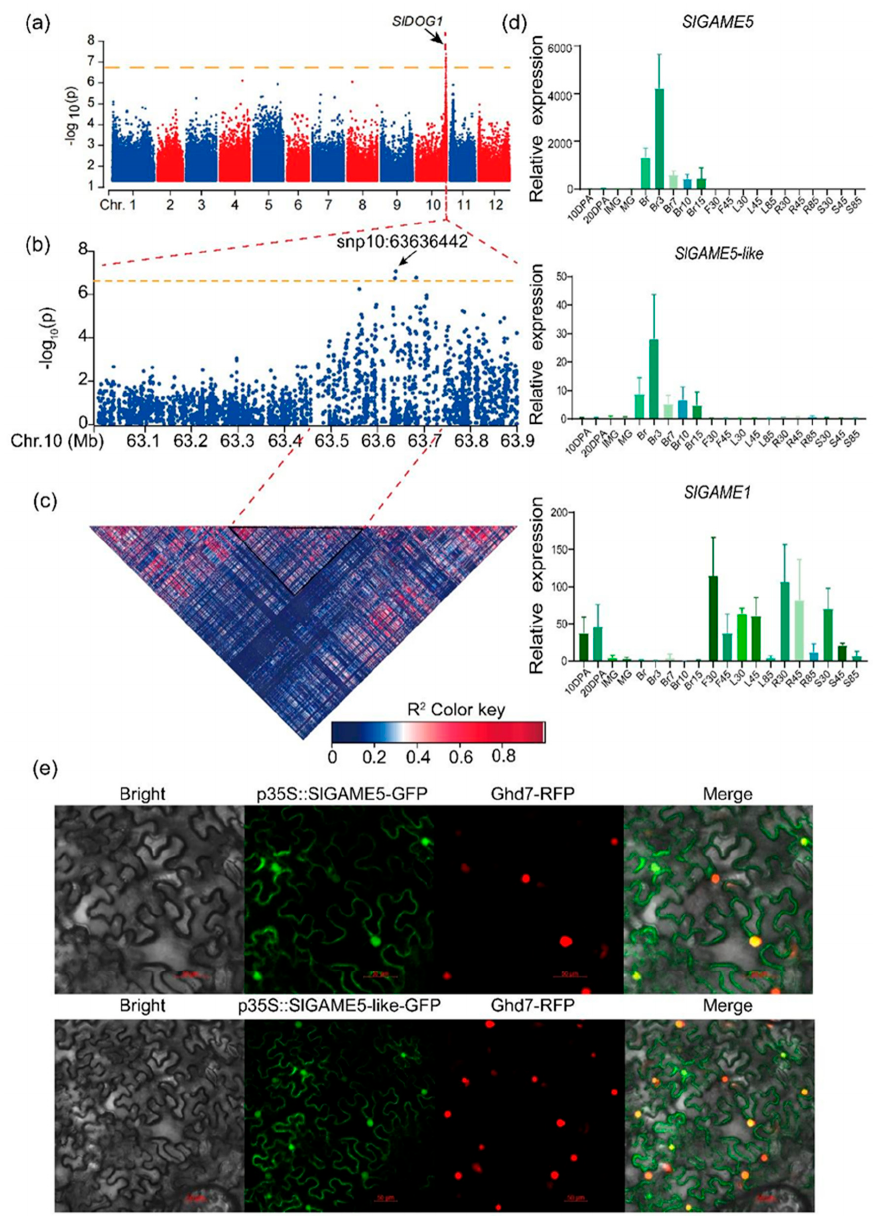
Figure 2. Identification and bioinformatic analysis of SlGAME5-like via genome-wide association mapping: ( a ) Manhattan plot showing the location of DOG1 , as identified using a GWAS of the glucoside metabolite content of steroidal alkaloids. ( b ) Gene model of SlDOG1 . ( c ) A representation of pairwise R 2 (a measure of LD) among all polymorphic sites within the ~200 kb region surrounding the most significant GWAS SNP 10:63636442. The color of each cell corresponds to its R 2 value, as described in the legend. ( d ) Transcriptome data showing the relative expression of SlGAME5 , SlGAME5-Like and SlGAME1 in different growth stages. Twenty samples from three key developmen- tal stages were collected for metabolic profiling and RNA-seq. The x -axis indicates the sample harvest date (DPG). Leaf (L), root (R), stem (S), bud (F30), and flower (F45) samples were harvested at the bud stage (30 DPG), flowering stage (45 DPG), and breaker stage (85 DPG). Fruit samples were harvested at the following stages: 10 DPA, 20 DPA, immature green (IMG), mature green (MG), breaker (Br), three days post-breaker (Br3), Br7, Br10, and Br15 [12]. ( e ) Nuclear localization of GFP-SlGAME5 and GFP-SlGAME5-like fusion proteins in the leaf epidermal cells of Nicotiana benthamiana . Bar = 50 µ